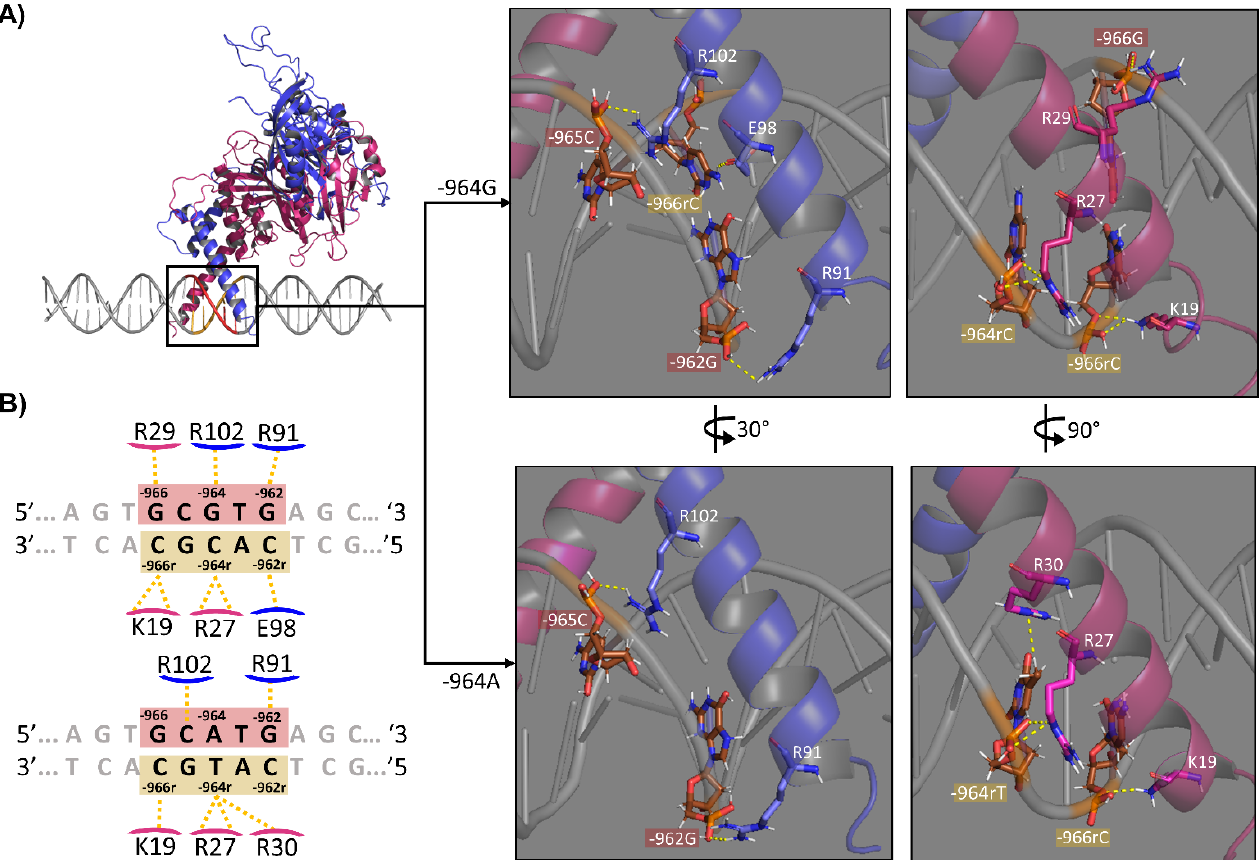
Figure 3. Intermolecular contacts of HRE (DNA) and HIF1 (protein) atoms, emphasizing the HLA-G − 964G > A polymor- phism. ( A ) 3D representation showing hydrogen bonds at the HIF1-HRE-964G/A complexes regarding the regulatory element. The central box is a 3D illustration of the HRE (highlight in red at the DNA structure, and its complementary sequence in sand) recognition by HIF1 bHLH domains and on the right are illustrated the details regarding hydrogen bonds formed between residue atoms of the ARNT (blue) and HIF1a (pink) with nucleotide atoms of the − 964G/A alleles. Hydrogen bonds (distance between 2.5–3.2 Å) are indicated by yellow dotted lines. The red boxes indicate HRE nucleotides (5 ′ -3 ′ ) and sand boxes indicate their complementary bases. Hydrogen atoms are colored in white, phosphate in orange, oxygen in red, and nitrogen in blue, while carbon is shown with different colors between partner molecules: DNA carbon in brown, HIF1a carbon in pink, and ARNT carbon in light blue. ( B ) 2D interaction diagram showing intermolecular contacts at the HIF1-HRE-964G/A complexes regarding the regulatory element. The red boxes indicate the HLA-G − 964G/A alleles at the HRE, considering the base pair. Hydrogen bonds are indicated by yellow dotted lines. The red boxes indicate HRE nucleotides (5 ′ -3 ′ ) and sand boxes indicate their complementary bases. Despite hydrogen bonds, VdW contacts at the HIF1-HRE complex also occur between residues-nucleotides (K128-966G, R102-964G, E98-963T, E98-962rC, S95-963T, H94-962G, and R91-962G in ARNT and R30-965C, R30-964rC, R30-963rA, and R23-965rG in HIF1a for the complex with the G allele, and R102-964A, R99-964A, E98-964A, H94-963T, and R91-963T in ARNT and R30-965C, R30-963rA, R23-965rG, and S22-966rC in HIF1a for the complex with the A allele, data not shown). Note: Author's own image. Regarding the HIF1-HRE-964G complex, five residues are bound to HRE by sugar- phosphate skeleton atoms (R91 and R102 for ARNT and K19, R27, and R29 for HIF1a), The − 964A allele altered HRE geometry in the complex HIF1-HRE-964A, resulting while only the E98 residue binding directly to the bases. The K19 and R27 amino acids in interaction loss between partner molecules, such as the hydrogen bonds between K19- form two hydrogen bonds with − 966rC and − 964rC nucleotides, respectively. For the 966rC and E98-962rC (Figure 3) observed to the complex with G allele. The number of hydrogen bonds formed between an amino acid and a nucleotide is directly